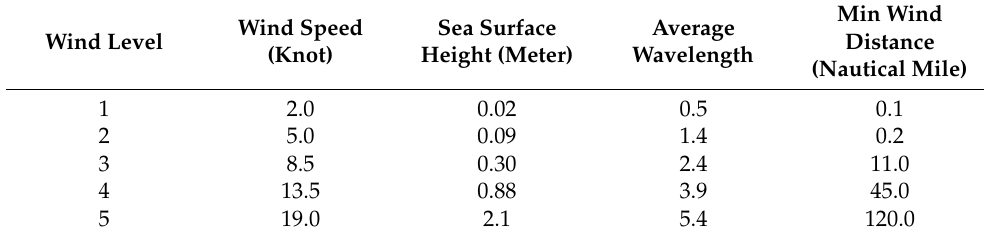
Table 3. Wave parameter statistics of different wind